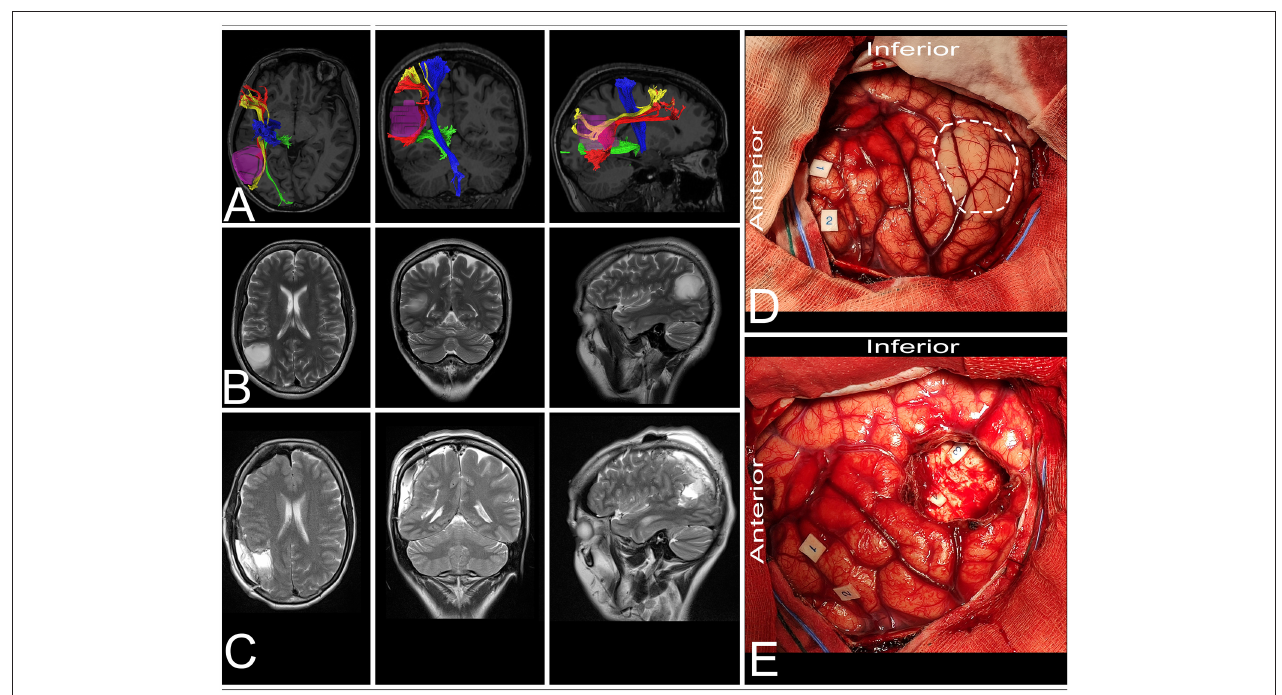
FIGURE 6 | 41-year-old right-handed women with a low-grade glioma within the non-dominant parietal lobe. (A) axial, coronal, and sagittal MRIs with diffusion tensor imaging tractography reconstruction of the tracts passing within the parietal lobe. The tumor (purple) is lateral to the AF (red), SLF II (yellow) and optic radiation (green), while posterior to the corticospinal tract (blue). (B,C) axial, coronal, and sagittal MRIs with preoperative and postoperative imaging. (D) Intraoperative photograph taken before tumor removal, after brain mapping. The tumor (white rectangle) was located posterior to the primary motor (tag 1 and 2) and sensory cortex. (E) Intraoperative photograph taken after tumor resection within functional borders, depth of resection is marked with optic radiation (tag 3) and SLF II (tag 4). Patient was operated in the lateral position with the head rotated to the left. DTI were reconstructed in DSI Studio (http://dsi-studio.labsolver.org) (